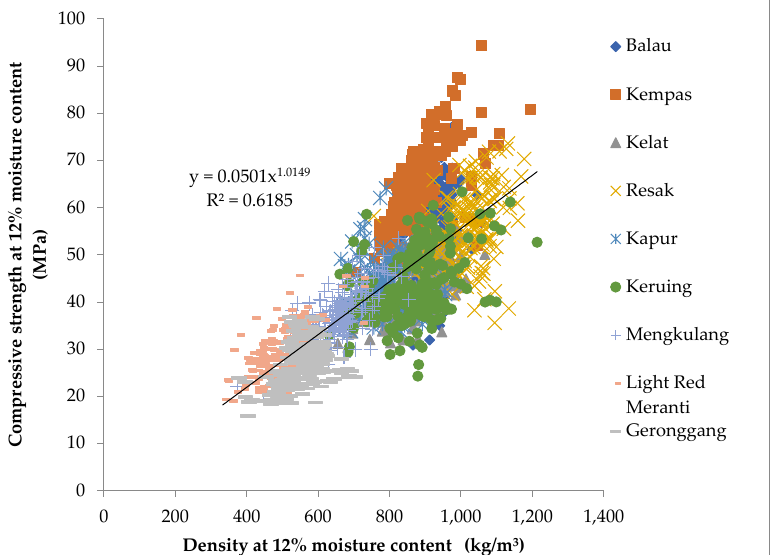
Figure 6. Relationship between compressive strength parallel to the grain and density for selected Malaysian tropical hardwood timbers.